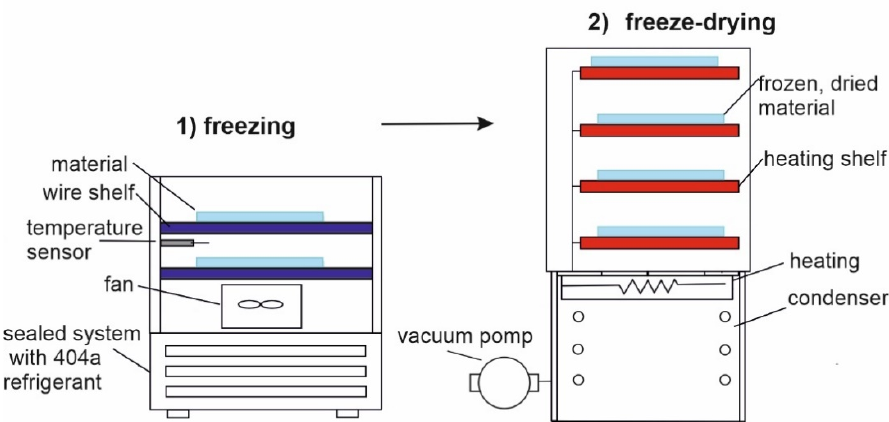
Figure 1. Scheme of lyophilization equipment.